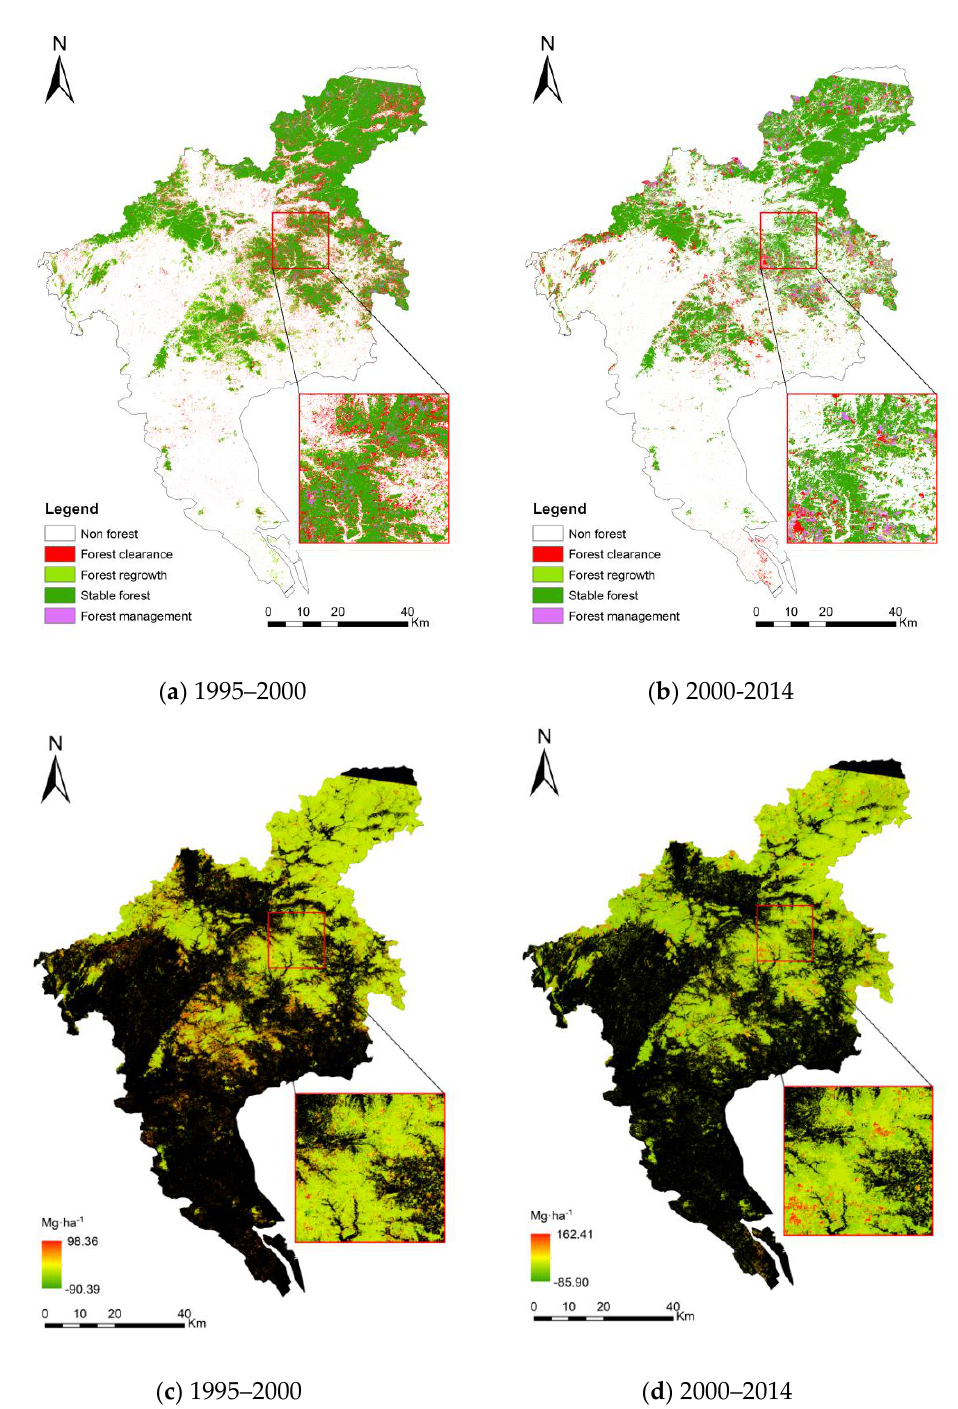
Figure 8. Spatial profile for the four forest activities over 1995 – 2000 ( a ), corresponding carbon flux ( c ), and those over 2000 – 2014 ( b , d ) in Guangzhou.